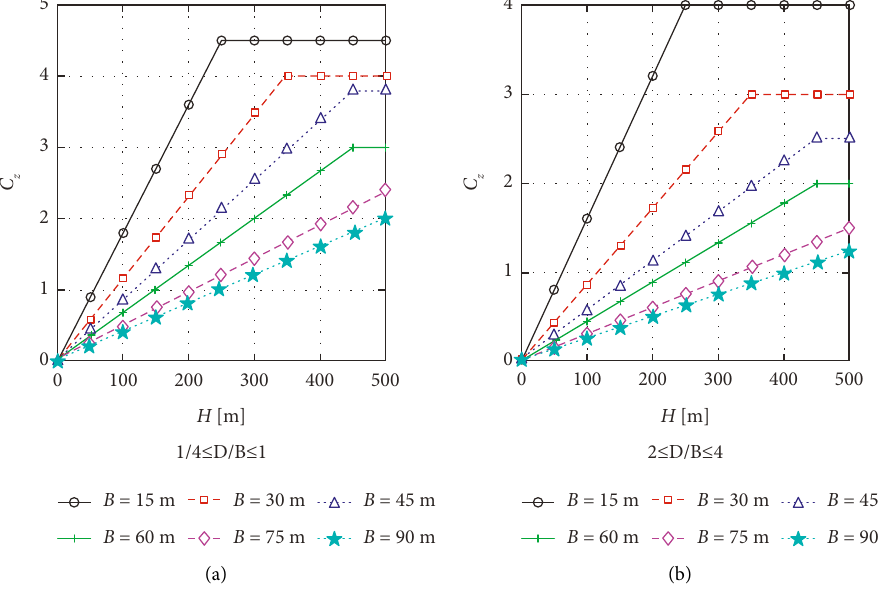
Figure 6: Proposed vertical decay constants for across-wind loads on rectangular tall Table 2: Suggested values of the parameters Δ